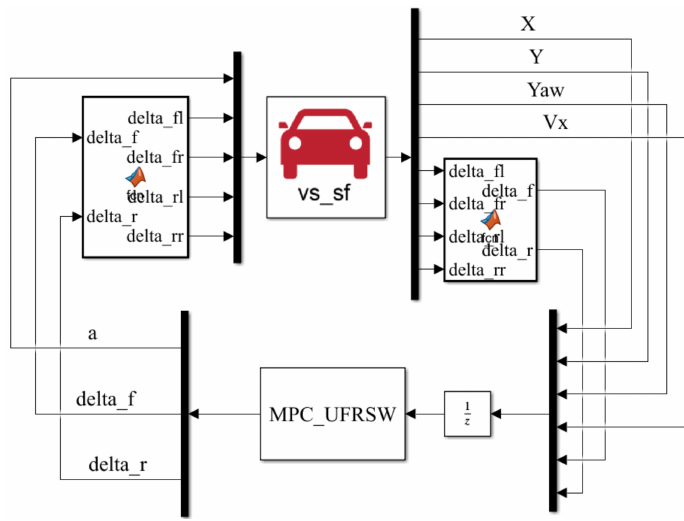
Figure 7. Carsim/Simulink co-simulation